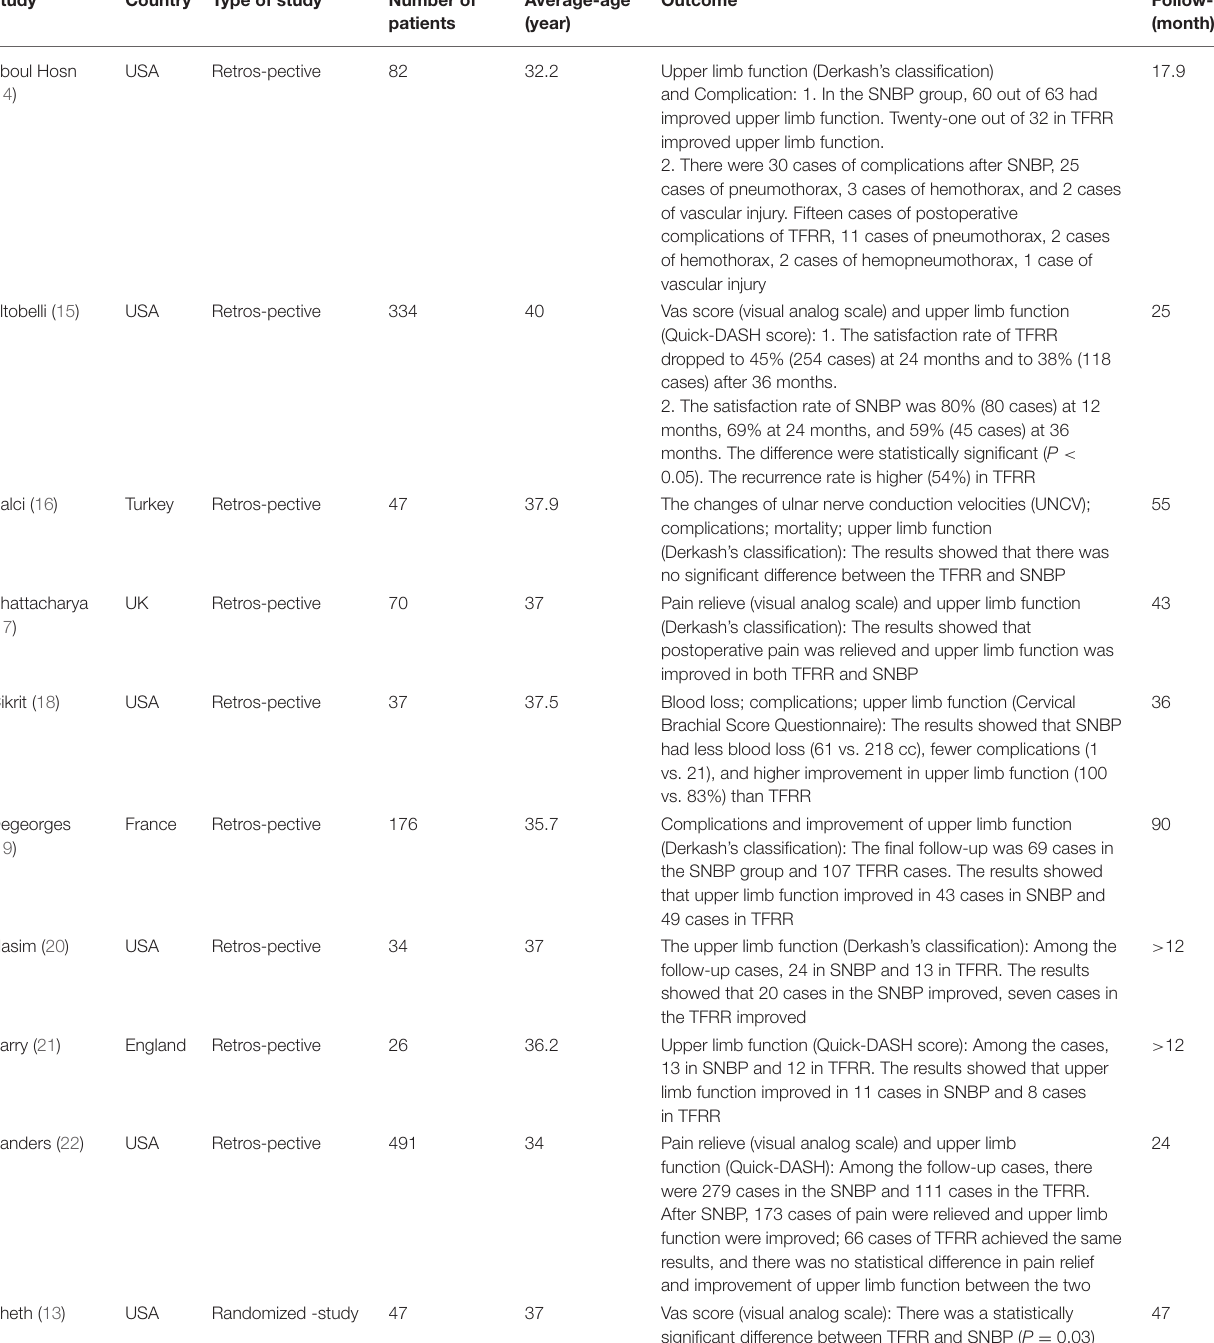
TABLE 1 | The characteristics of included studies.